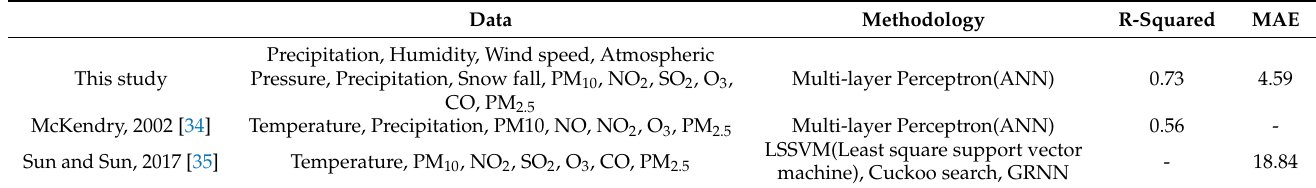
Table 12. Next-day PM2.5 prediction model performance comparison.